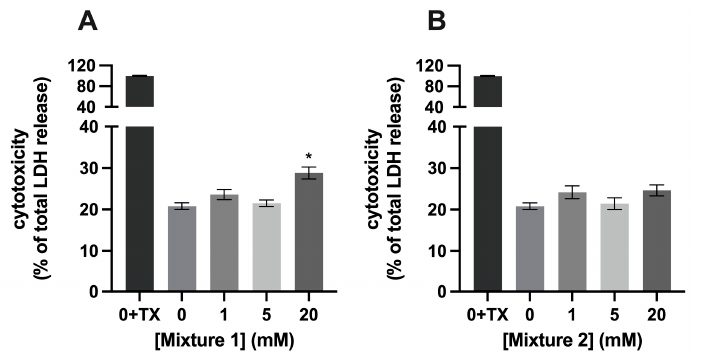
Figure 2. Cytotoxicity in C2C12 myotubes exposed to single SCFAs. Concentrations of 1, 5, and 20 mM of acetate ( A ), propionate ( B ), and butyrate ( C ) exposed for 24 h were not cytotoxic to C2C12 myotubes. Cytotoxicity is shown as a percentage of LDH activity seen after complete cell lysis (addition of 3% TX-100) and expressed relative to cytotoxicity shown at exposure to 0 mM ( N ≥ 5; n = 2). All data are presented as mean ± SEM.